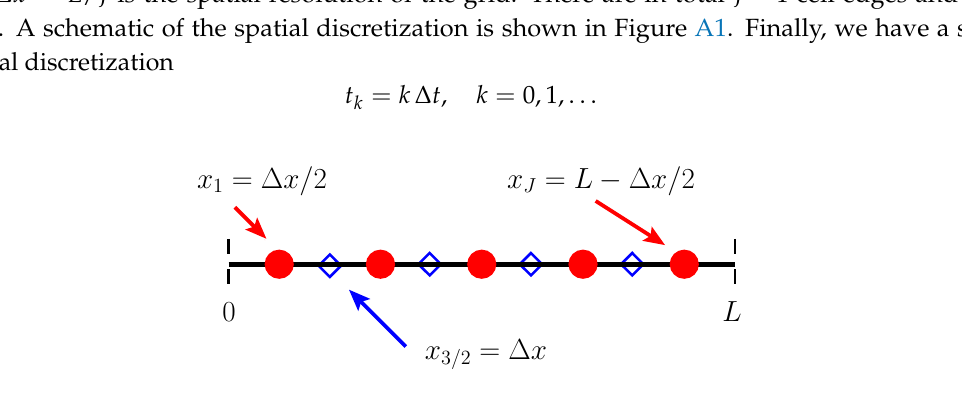
Figure A1. A schematic representation of our computational grid for J = 5. Dashed vertical black lines indicate the boundaries of the computational domain. Circles indicate cell centers, while diamonds indicate cell